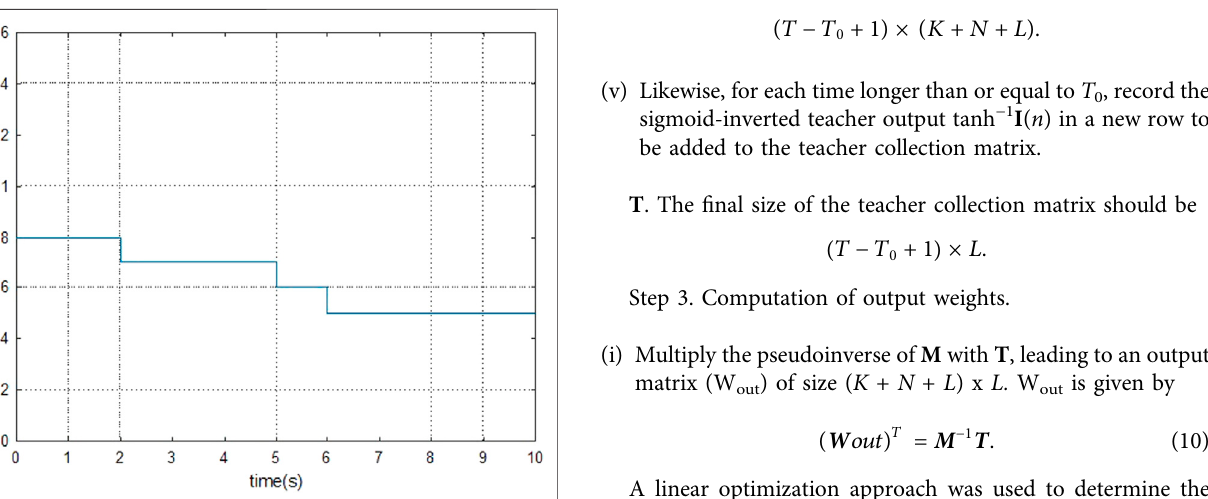
FIGURE 9 | Variation of the duty cycle for a bigger step size of Δ δ =